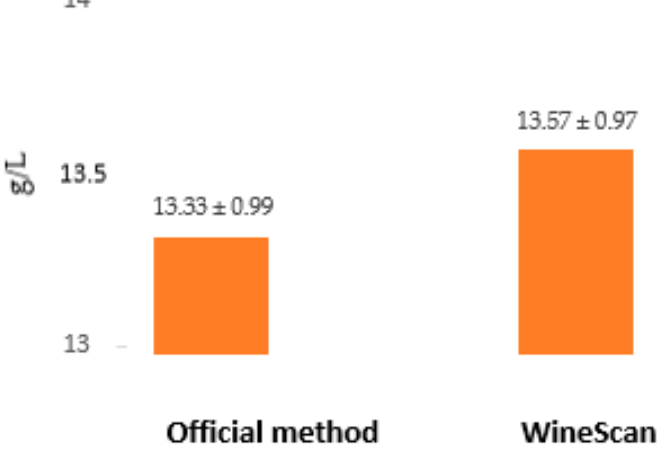
Figure 6. Average of alcohol concentrations in wine samples determined by official method and WineScan technology.